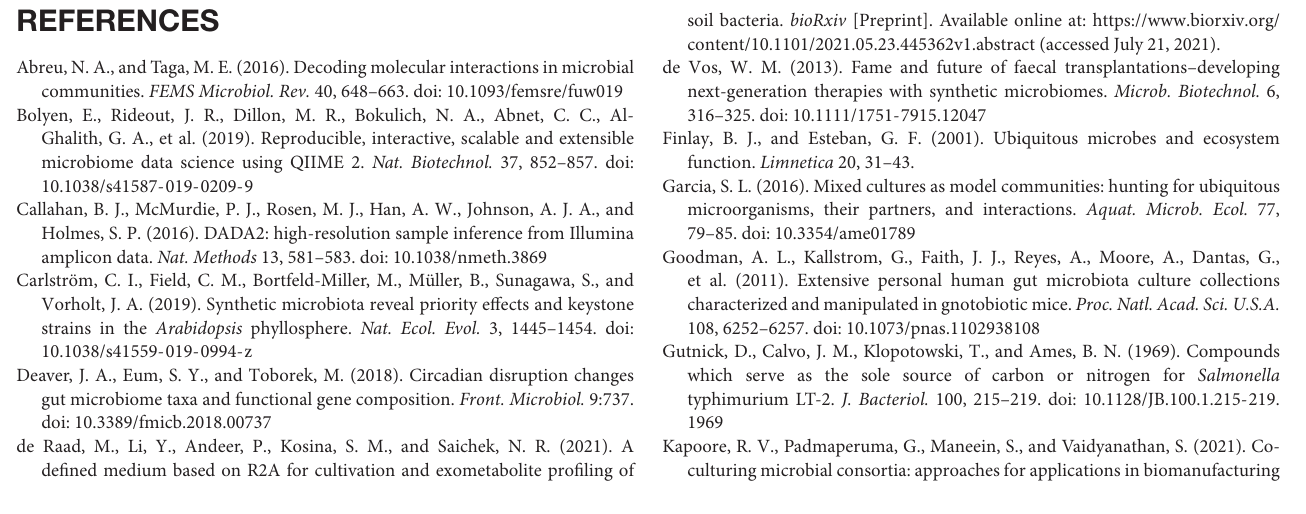
Supplementary Figure 1 | Bacterial α -diversity (Shannon, Faith’s PD and Observed OTUs indices) in Pre-SSC and SSC communities in soil and fecal samples. Supplementary Figure 2 | NMDS visualization of Pre-SSC and SSC microbial communities in soil and fecal samples. Supplementary Figure 3 | Analysis of MAGs by DRAM generates a profile that can be utilized to compare functions across complexes, metabolic and enzymatic pathways. ETC complex I: ubiquinone oxidoreductase, ETC complex II: succinate dehydrogenase, ETC complex III: cytochrome c reductase, ETC complex IV: cytochrome c oxidase, ETC complex V: ATP synthase. Environmental pressure for the carbon-based SSC here refers to the use of Polyethylene Glycol (36% w/v) to the carbon-based medium to induce a low-moisture condition. Supplementary Table 1 | Taxonomic assignment of ASVs and counts (Kingdom, Phylum, Class, Order, Genus, Species) in pre-SSC and SSC from soil and fecal samples based on 16S rRNA V4 amplicon. Supplementary Table 2 | Metagenome-assembled genomes (MAGs) statistics – total length, number of contigs, N50, GC contents, completion and redundancy percentage, and summary of functional potential. Supplementary Methods 1 | Metagenomic analyses